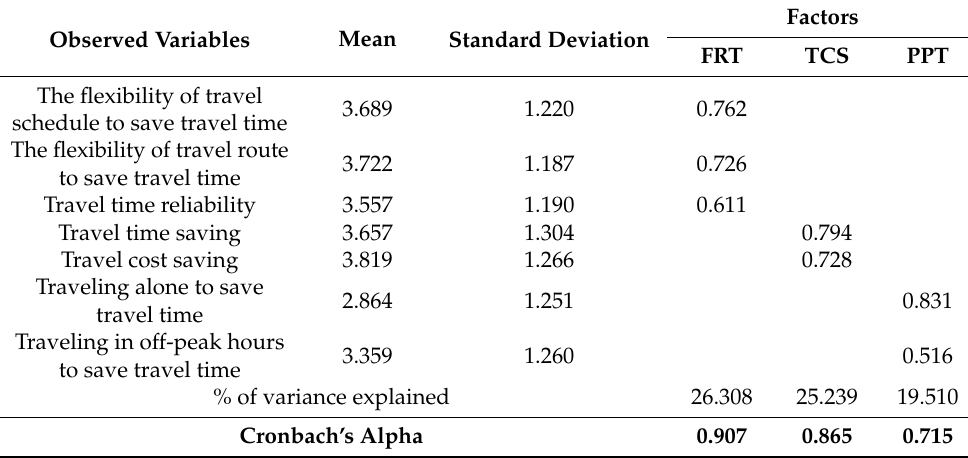
Table 2. Rotated factor loadings of important travel time saving attributes.